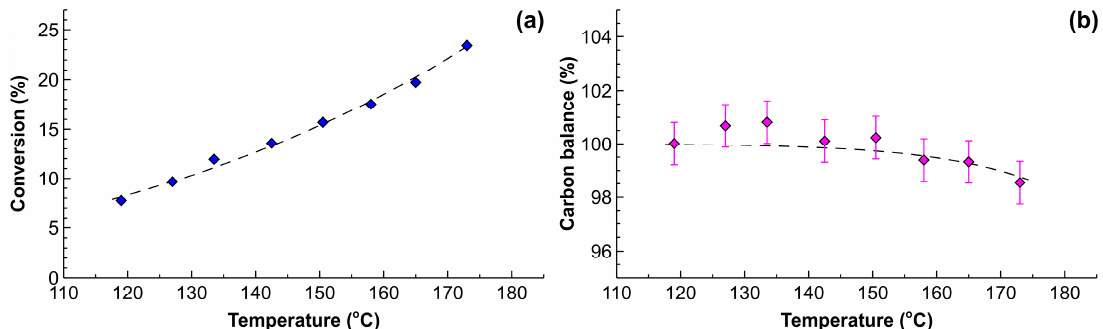
Figure 9. ( a ) The MBY conversion and ( b ) carbon balance as a function of reaction temperature obtained in a 80 cm reactor coated with a 5 wt% Pd/ZnO catalyst. Reaction conditions: solvent-free MBY flow rate of 4 mL min − 1 , H 2 flow rate of 1 L min − 1 and the outlet pressure of 15 bar.